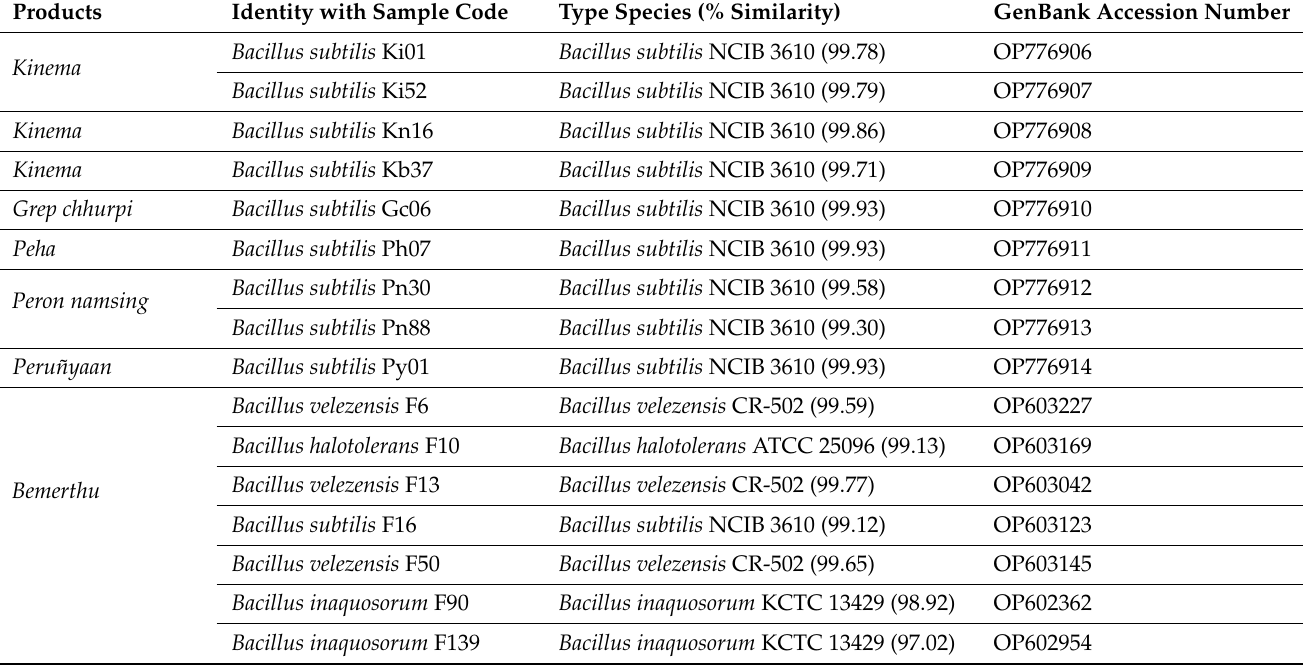
Table 3. Identifications of fibrinolytic-producing bacteria from naturally fermented soybean, of the Eastern